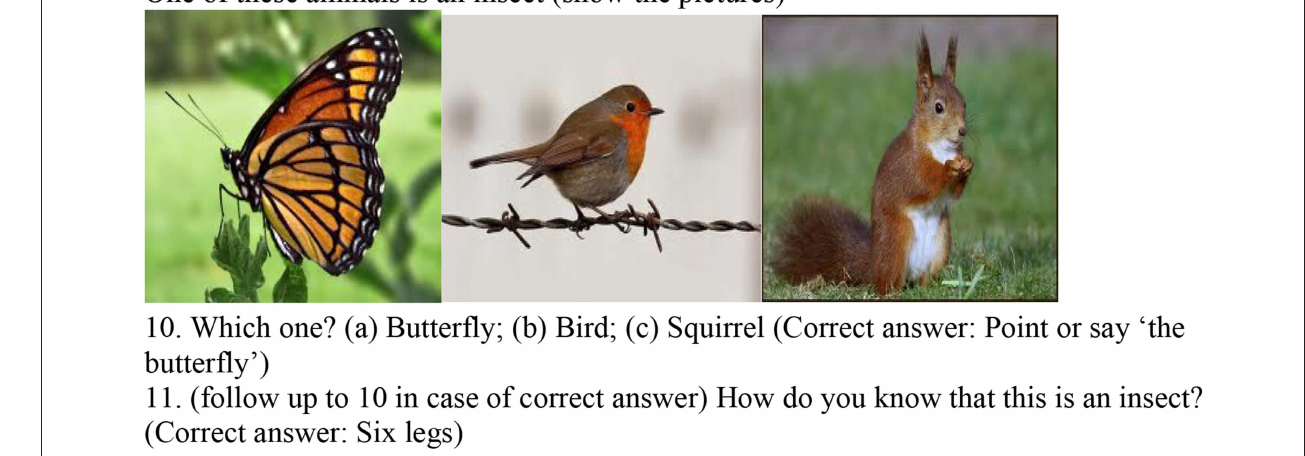
FIGURE 1 | Schematic representation of the items 10 & 11 of the Greek version of